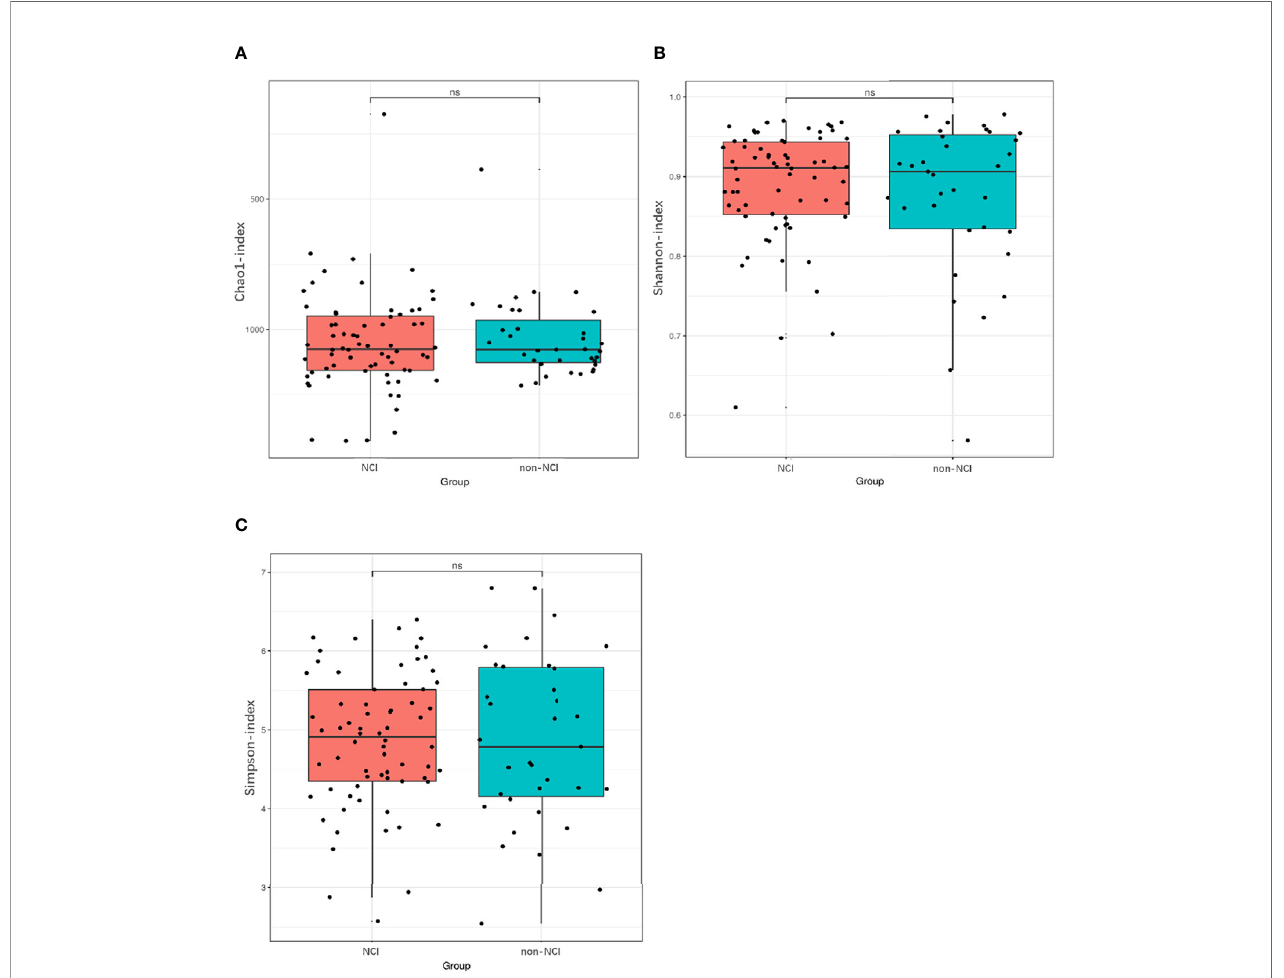
FIGURE 1 | Differences in a -diversity of gut microbiota between NCI and non-NCI groups. NCI group, HIV-infected persons with neurocognitive impairment; non- NCI, HIV-infected persons without neurocognitive impairment; ns, not signi fi cantly different a -diversity of gut microbiota from the NCI group compared with the non- NCI group. Statistical signi fi cance was set at P = 0.05. (A) Chao1 index, (B) Shannon index, and (C) Simpson